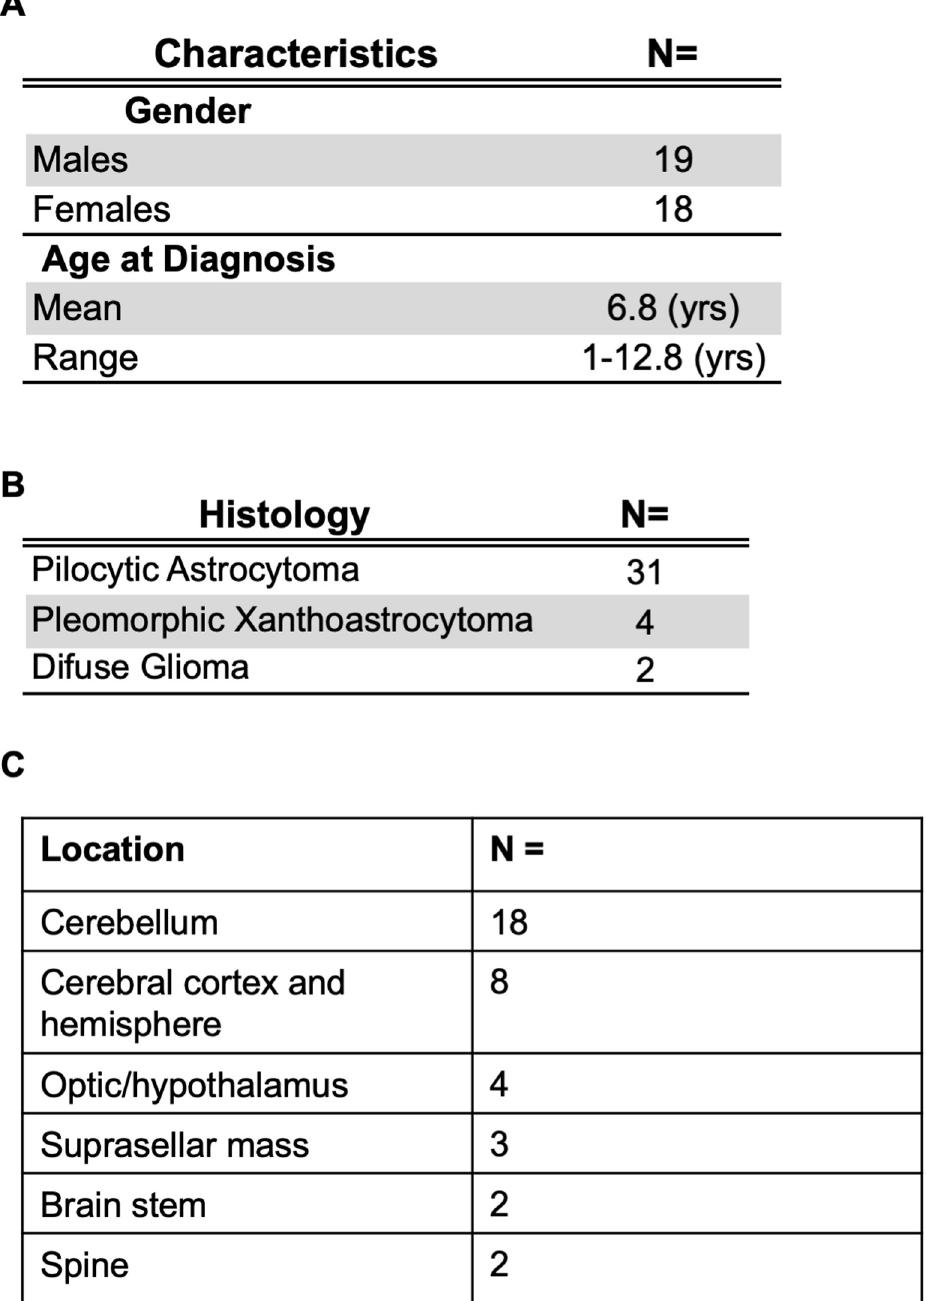
Fig 1. Analysis of the SA LGG cohort. (a) Patient demographics, (b) pLGG tumor histology, and (c) tumor